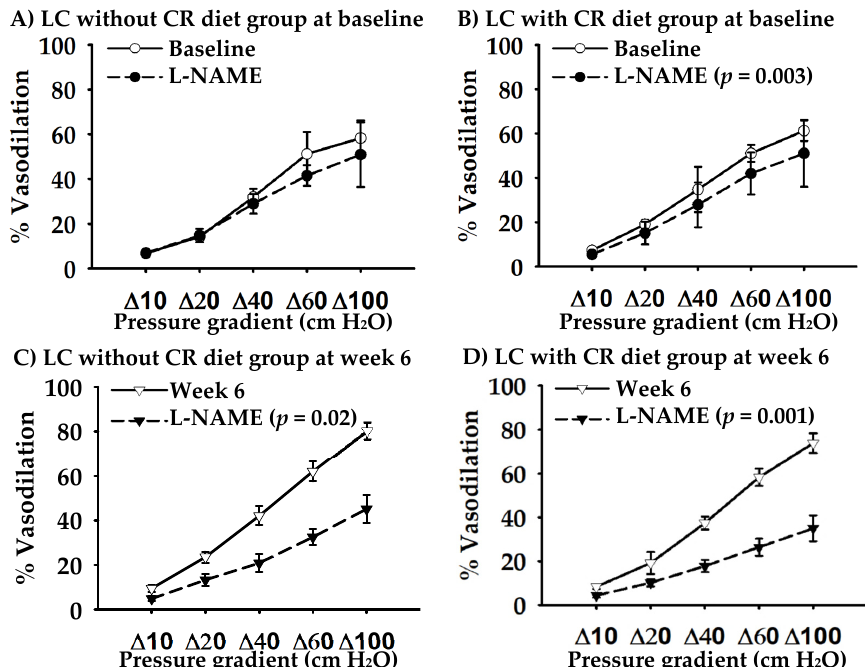
Figure 2. Arteriolar flow-induced dilation at baseline and after the 6-week low-carbohydrate (LC) diet intervention without caloric restriction (CR) diet ( n = 5) and with CR diet ( n = 8). Endothelial nitric